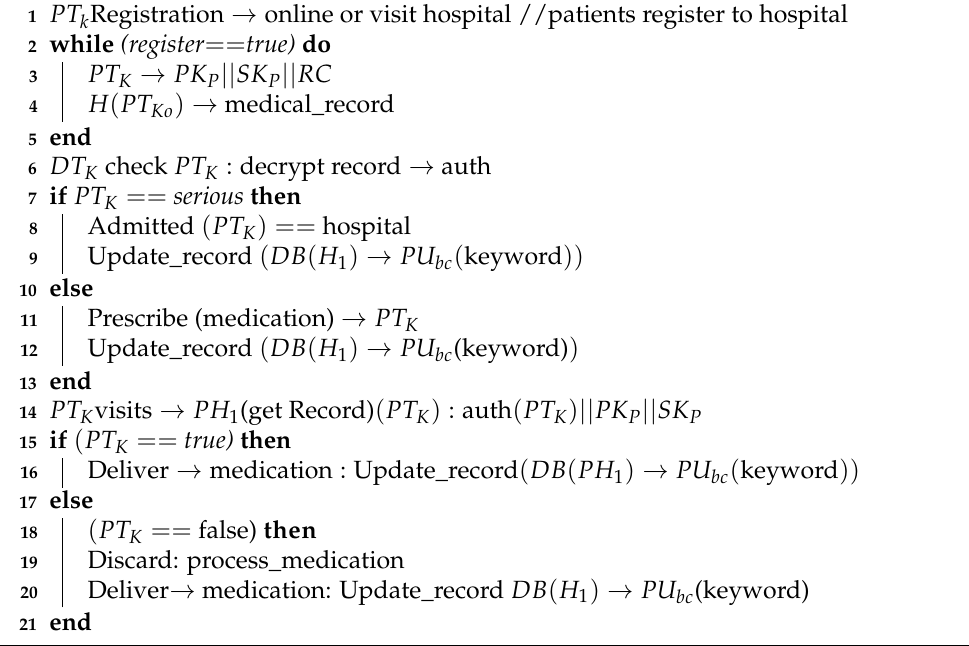
Algorithm 1: Patient visits the Hospital/GP for a specific